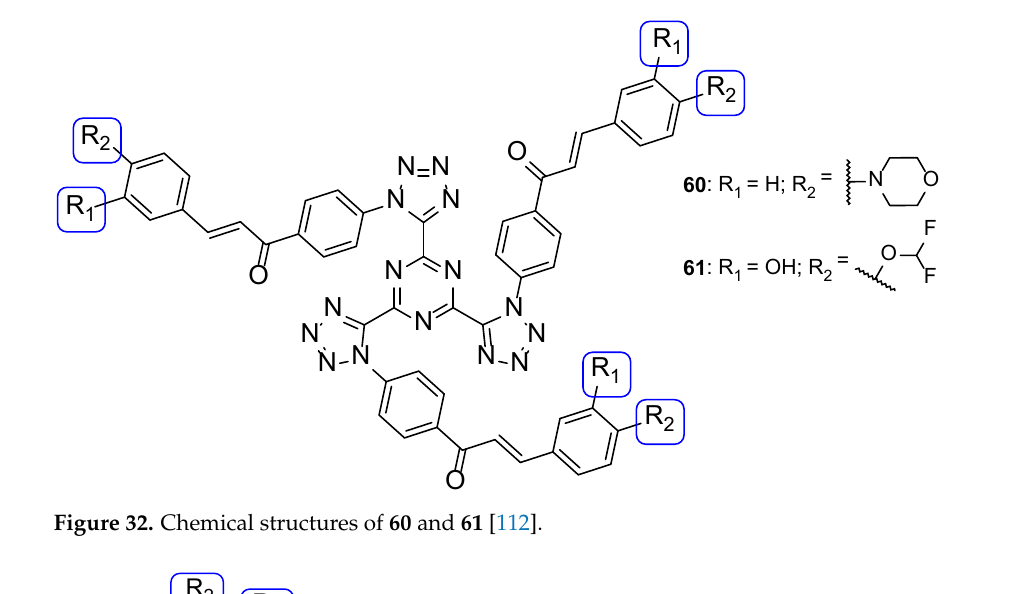
Figure 32. Chemical structures of 60 and 61 [112]. Benzothiazole-tetrazole hybrids were synthesized by Shanmugapandiyan and At-